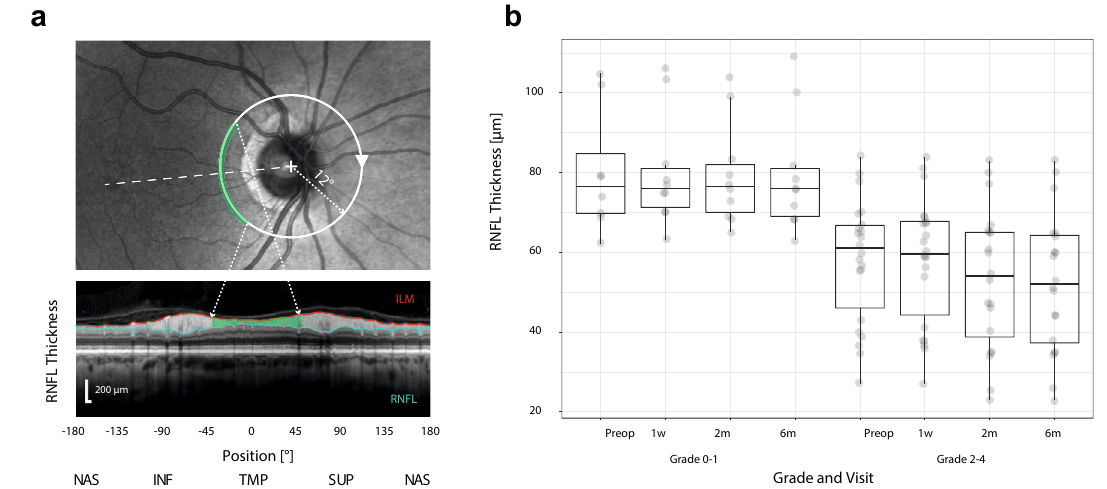
Figure 1. Example from a preoperative OCT examination of patient #8. In the upper panel, the circular scanning trajectory of 3.4 mm diameter centered on the optic nerve disc is depicted on the scanning laser ophthalmoscopy image. The green circular slice represents the temporal part of peripapillary RNFL. In the bottom panel, the green area marks the evaluated temporal RNFL thickness delineated by the internal limiting membrane (ILM) and the interface between the axonal fibers and the bodies of the ganglion cells ( a ). Distribution of the temporal RNFL thickness in preoperative and three postoperative visits separately for patients with a grade of compression 0–1 and 2–4. The grade factor was statistically significant (p = 0.180 × 10 –6 ). The lower and upper hinges of the boxplots represent the 25th and 75th percentiles, respectively; the whiskers extend to an outlier but not farther than 1.5 times the interquartile range. The boxplot overlays the individual values represented as gray circles spread along the horizontal dimension to avoid overlapping ( b ).